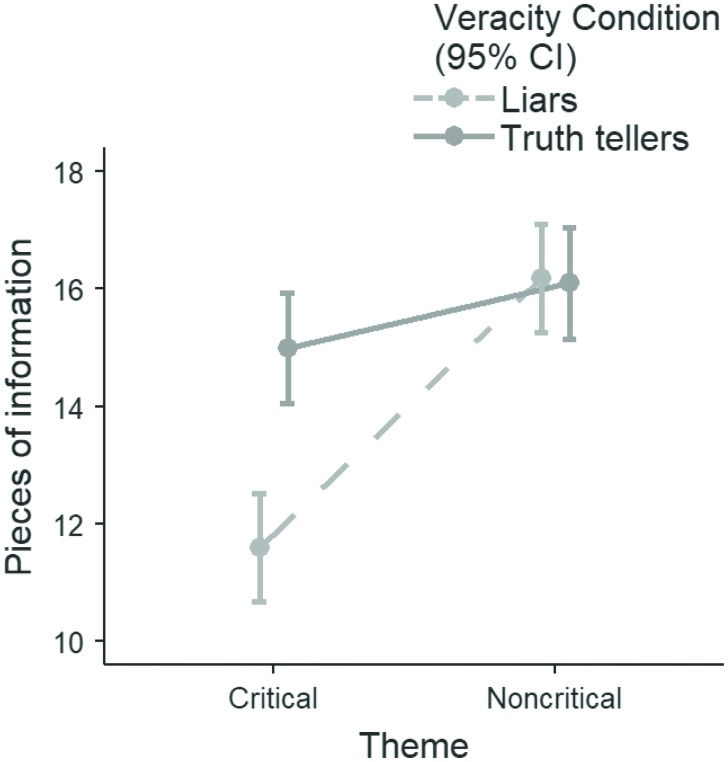
Theme by Veracity interaction. Y-axis shows the amount of revealed information.